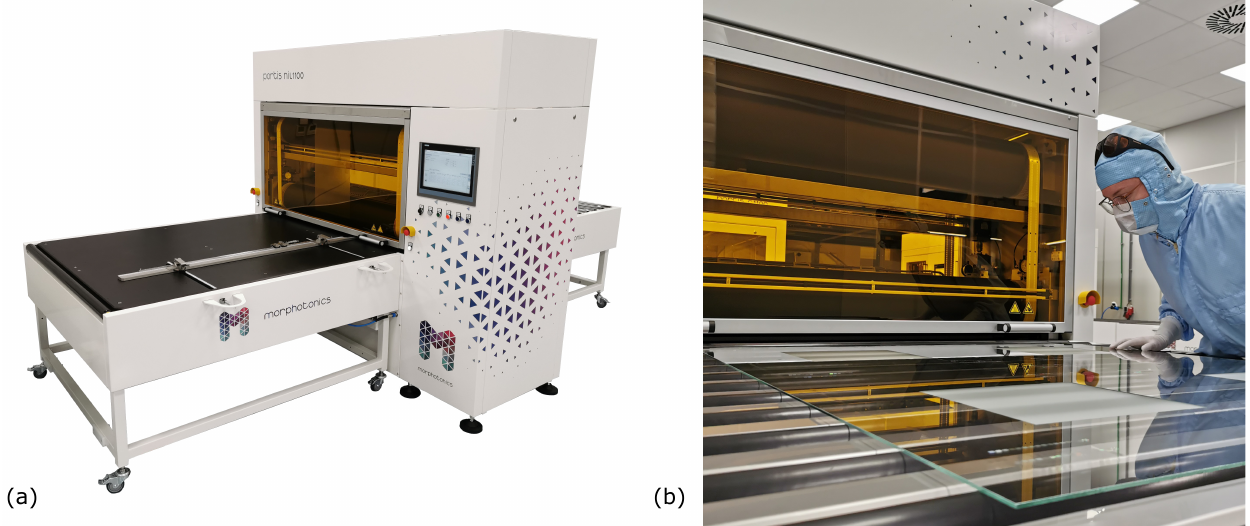
Figure 4. ( a ) Morphotonics Portis NIL1100 roll-to-plate nanoimprint equipment [20]. ( b ) Detailed view of the rollers inside the Morphotonics Portis NIL1100 nanoimprint tool. Table 1. Properties of the imprint resins. The viscosities are measured at 25°C.